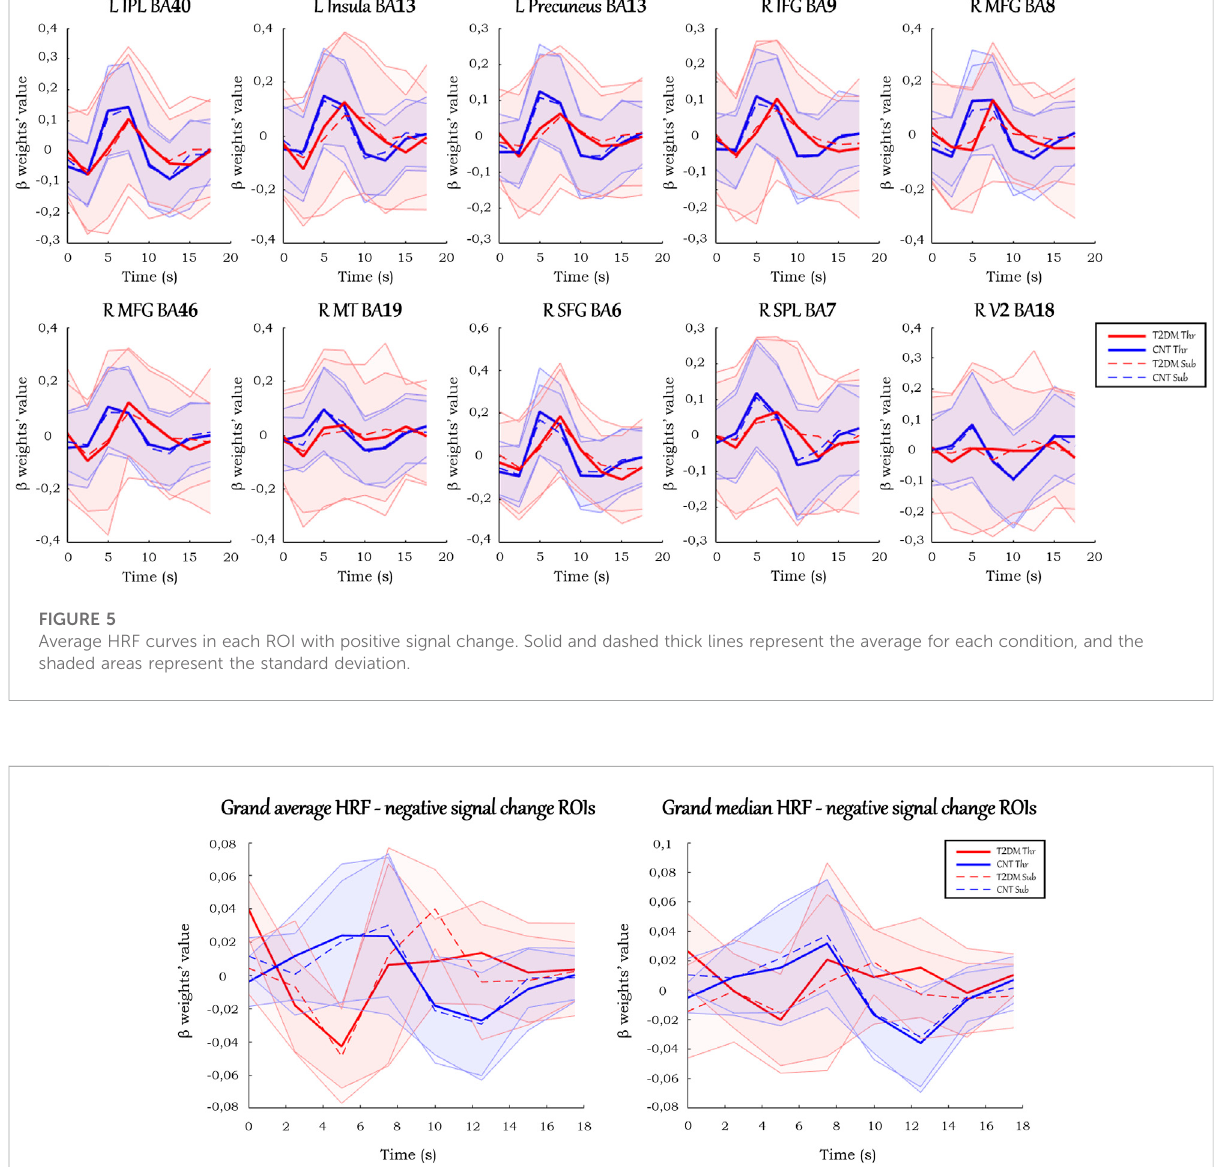
FIGURE 6 Grand average and grand median HRF curves in the ROIs with negative signal change. Solid and dashed thick lines represent the average/ median for each condition, and the shaded areas represent the standard deviation/interquartile